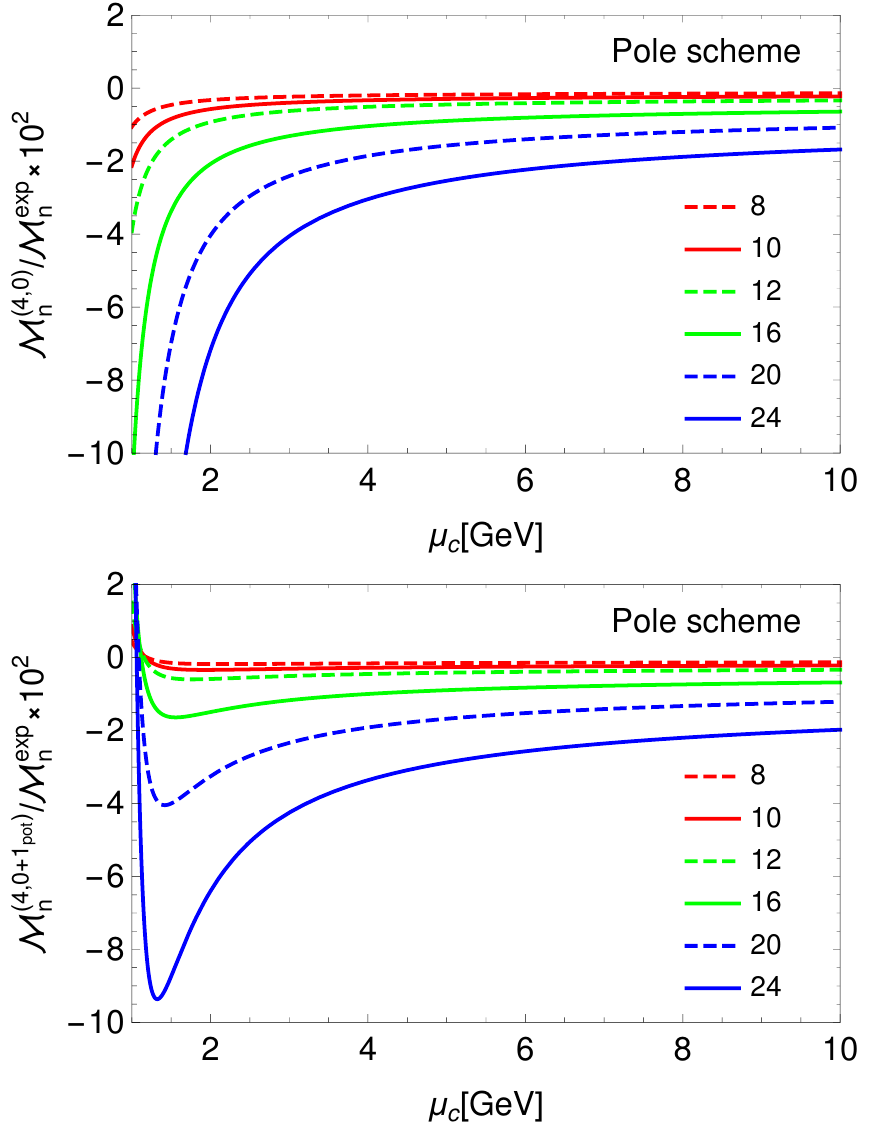
Figure 8 . Dimension-four corrections to various non-relativistic moments relative to the exper- imental moments from [5]. The upper panel shows the leading order contribution and the lower panel the leading order contribution plus the potential corrections. The relative corrections have been rescaled by a factor of 100.